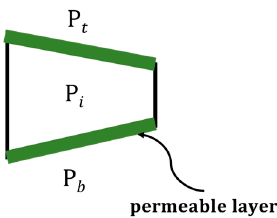
Figure 2. Normal fracturing flow for permeable cohesive surfaces.